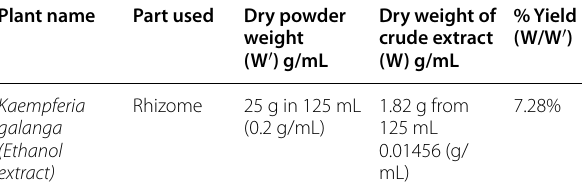
Table 1 Extractive yield (%) obtained from the ethanol extract of K. galanga